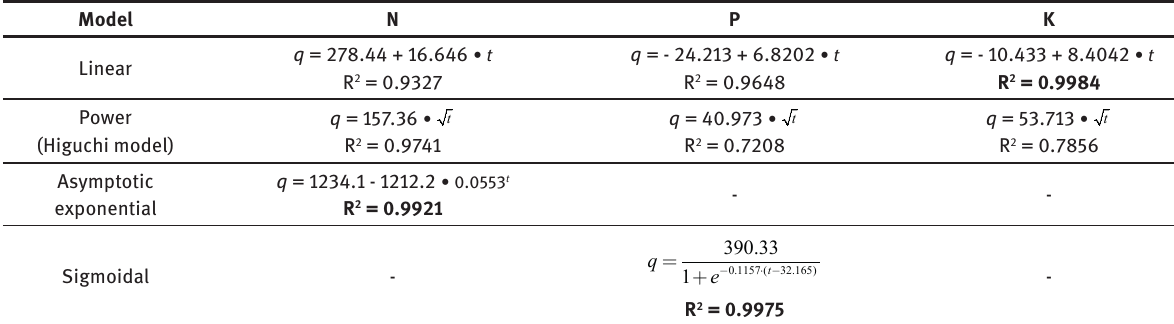
Table 3: Kinetic equations, parameters and coefficients of determination.